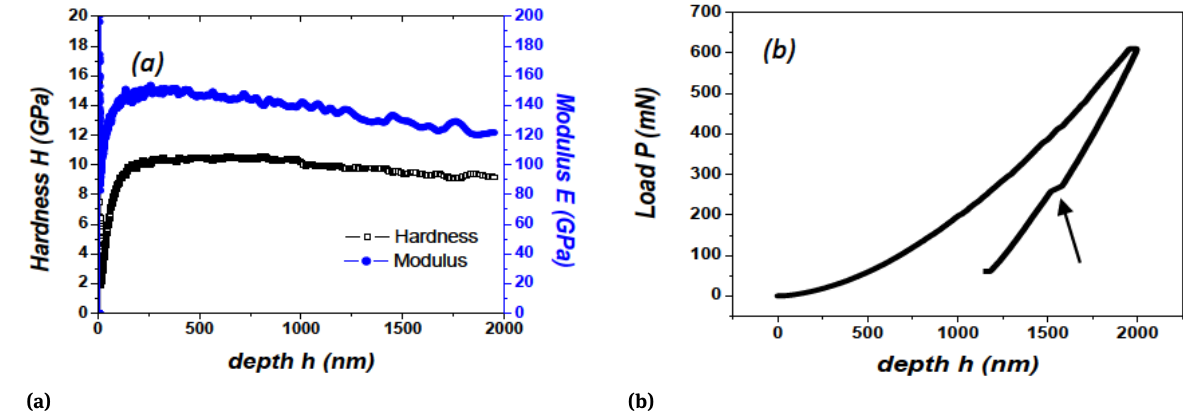
Figure 13: (a) Hardness and modulus variation with indentation depth and the corresponding (b) Load-depth curve bare Silicon